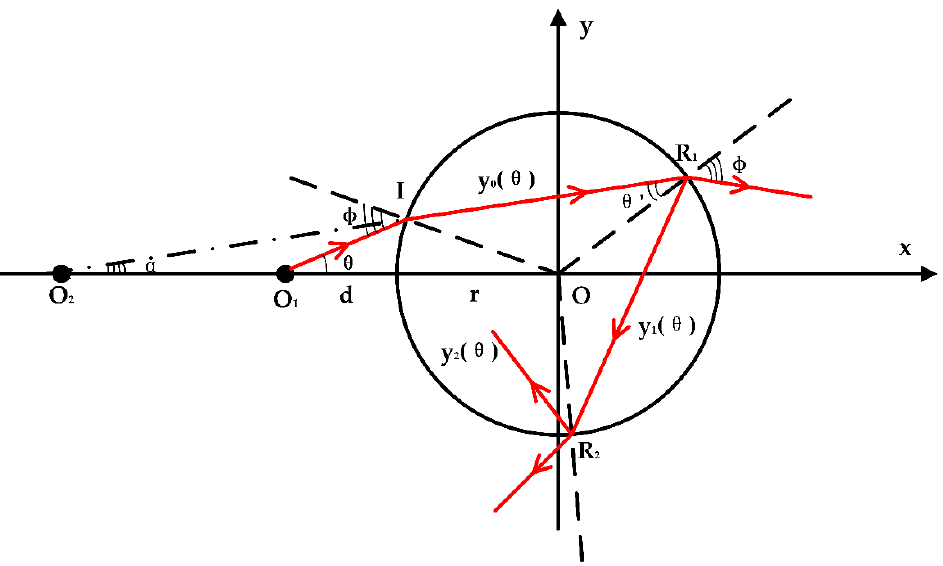
Figure 3. Schematic of ray-tracing.